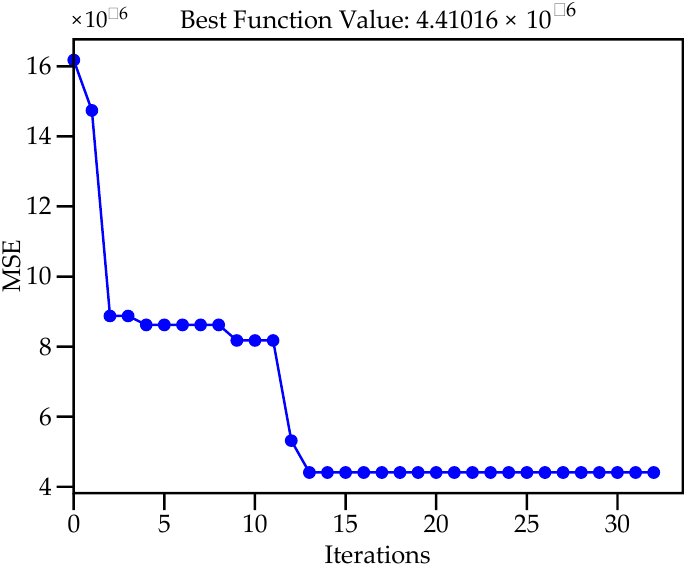
Figure 10. Convergence curve of PSO algorithm.